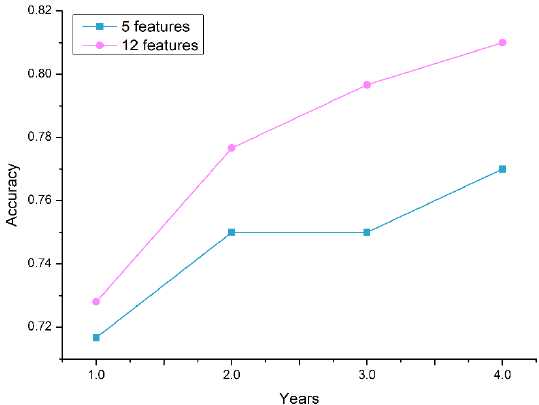
Figure 6. Accuracy comparison between the selected 12-feature set and the traditional predictors (5-feature set) using a different number of years for training data.